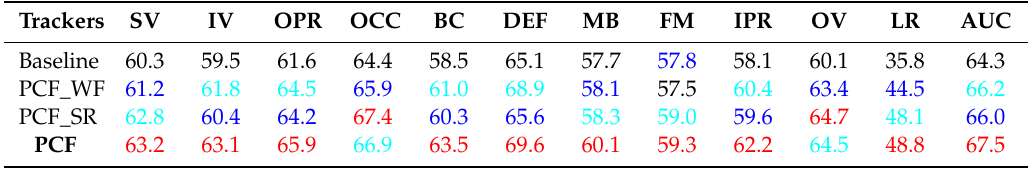
Table 3. The SP of the OPE for the baseline tracker, the proposed PCF tracker and the trackers of progressively integrating the presented strategies on di ff erent attributes (%): SV, IV, OPR, OCC, BC, DEF, MB, FM, IPR, OV, LR. The last column is the AUC which represents the average overlap accuracy of the OPE. The top three ranks are marked in red , cyan , and blue separately. Trackers SV IV OPR OCC PCF_WF 61.2